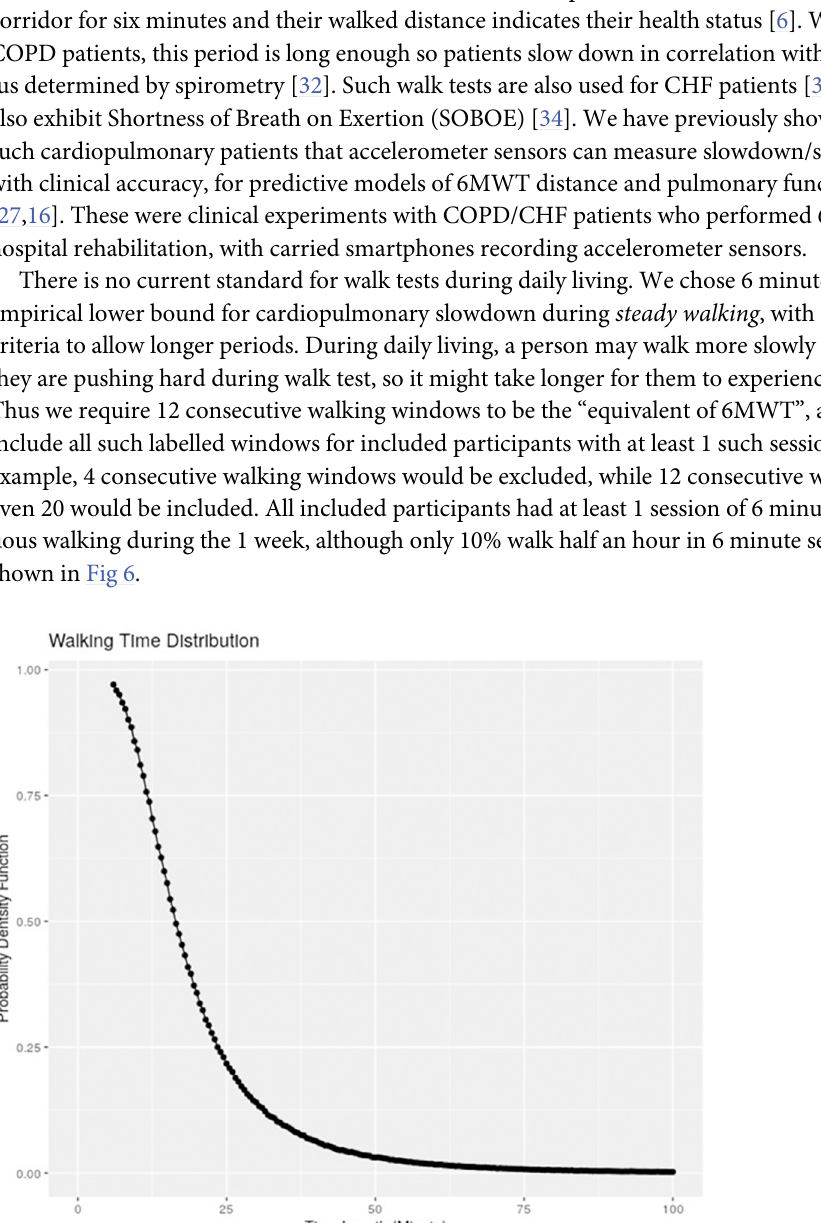
PLOS Digital Health | https://doi.org/10.1371/journal.pdig.0000045 October 20,